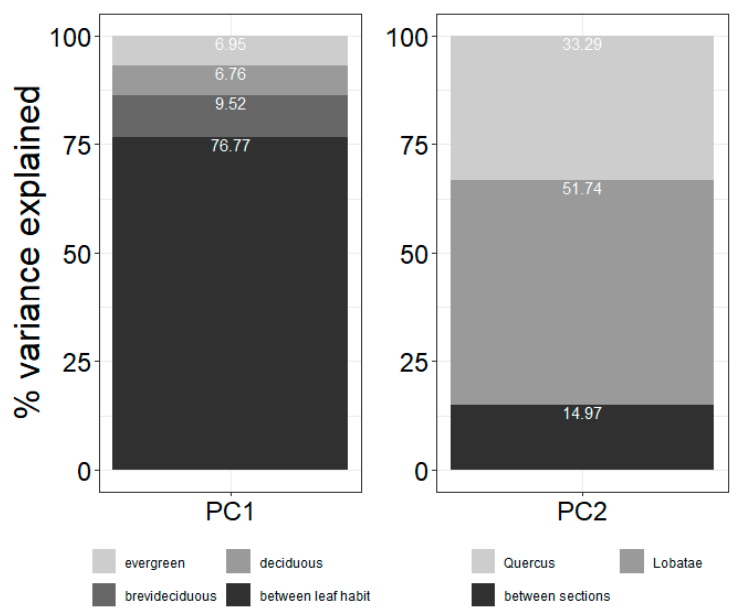
Figure 2. Variance explained by the main factor in PC 1 and PC 2 axis on the nested random effect models. The main explicative factor in PC 1 was leaf habit and in PC 2 was carried by sections.